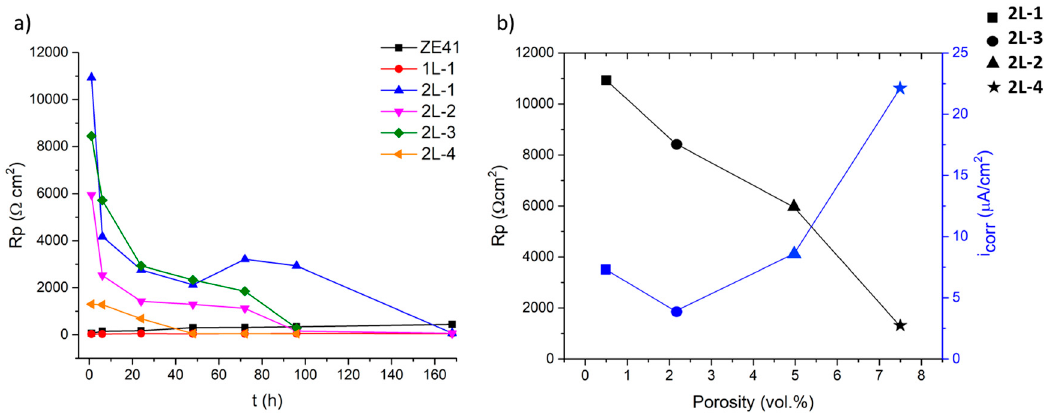
Figure 14. ( a ) Polarization resistance ( Rp ) values vs. immersion time in the NaCl 3.5 wt.% of the uncoated ZE41 magnesium alloy and the WC-Co coated systems. ( b ) Relation between Rp and i corr values at 1h immersion with porosity degree for the different two-layers coated samples.